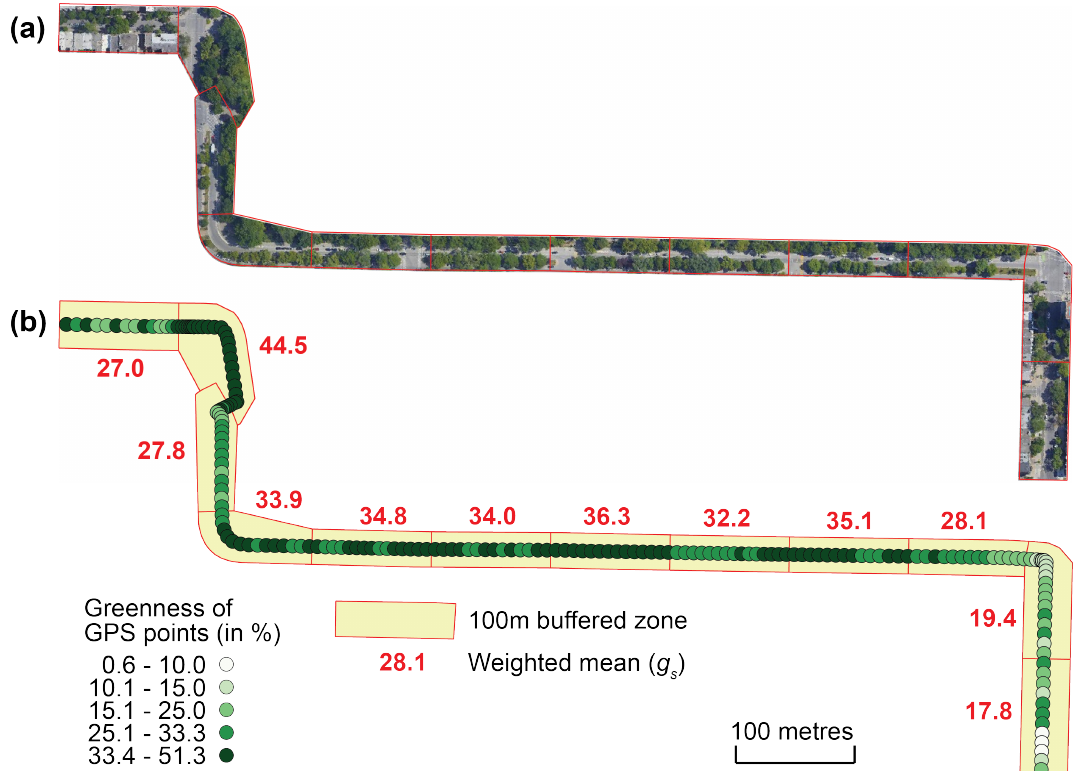
Figure 7. Mapping results along a route. ( a ) Google Maps imagery and 100 m buffered segment in red. ( b ) GPS points and 100 m buffered segments. The greenness of the GPS points is defined as the percentage of trees detected in the image using